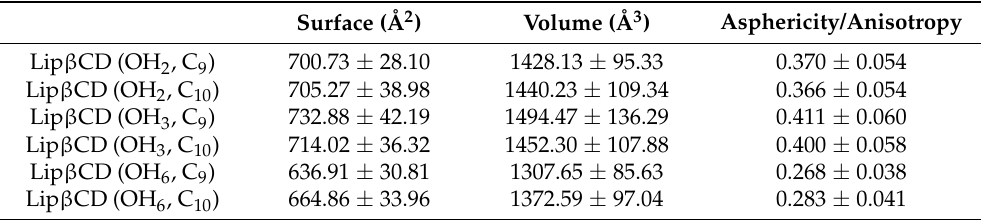
Table 2. Average surfaces, volumes and average anisotropies of the radius of gyration tensor computed for the 12 families of Lip β CD isomers. A value of zero corresponds to a sphere-like structure, and a value of one to a rod-like